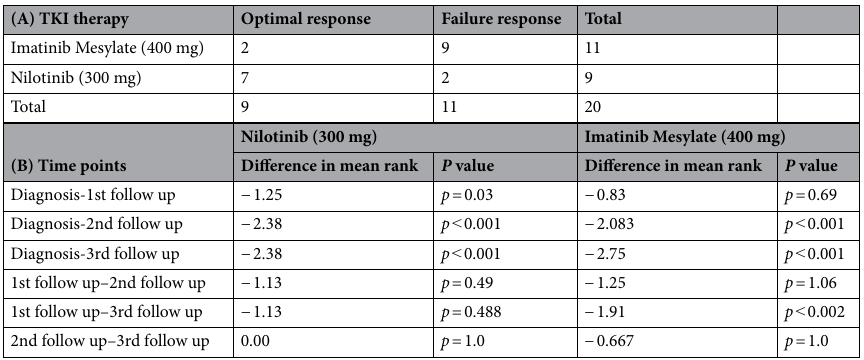
Table 2. (A) Contingency table of TKIs therapy with outcome response. *CML patients with IM 600 mg excluded from fisher exact estimation. (B) Test Statistics of effect of Nilotinib and Imatinib Mesylate on neutrophils.